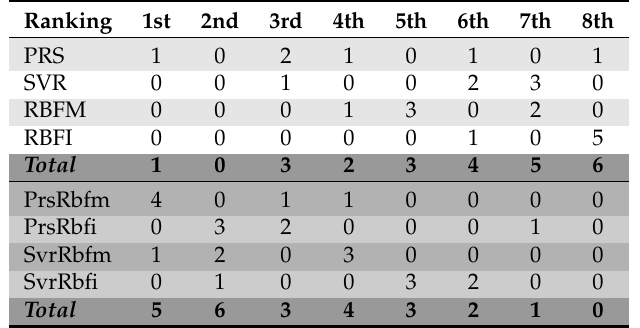
Table 6. Frequency of the accuracy ranking (using MAE) of the metamodels for the six benchmark ( k + 1 )( k + 2 ) problems with 3 training 2